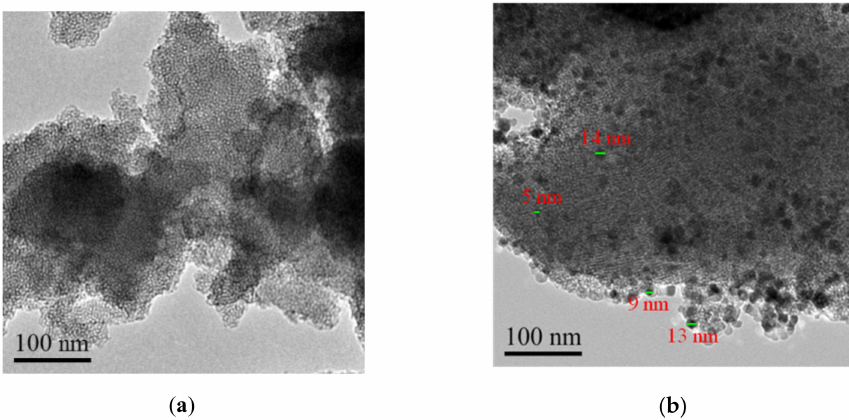
Figure 2. TEM images of MCM-41 ( a ) and Ba(II)/TiO 2 /MCM-41 ( b